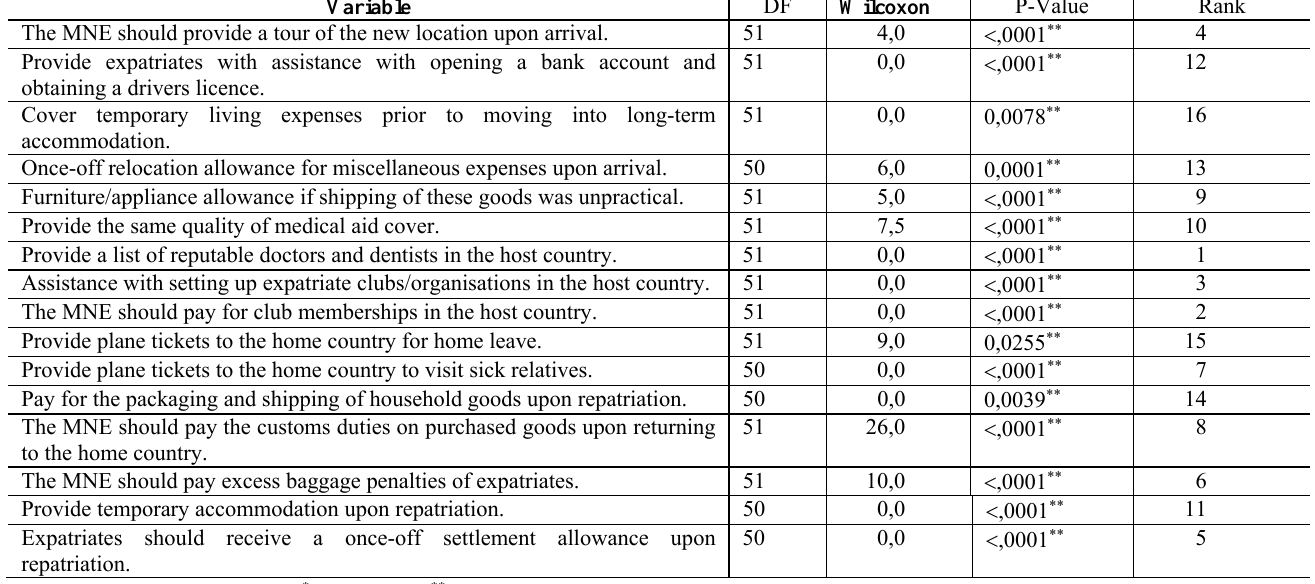
Table 3: Wilcoxon test for support required vs. provided Variable DF Wilcoxon P-Value Rank 51 4,0 < ,0001 ∗∗ 0,0